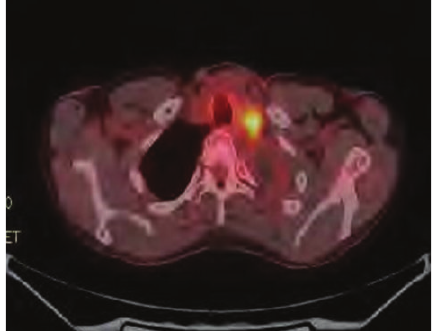
Figure 2: Neck CT: A reveals a large heterogeneous mass that has replaced the left lobe of the thyroid gland.